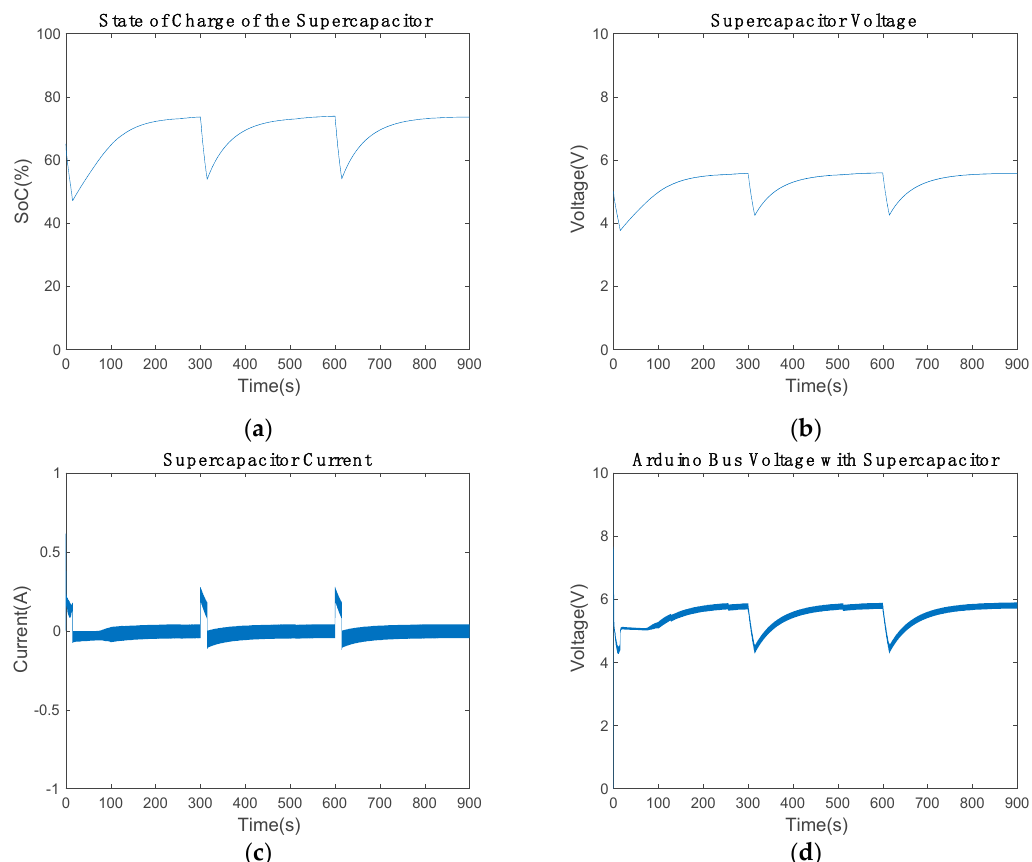
Figure 13. Medium-power harvester results: ( a ) state of charge during 900 s, ( b ) voltage of the Sensors 2020 , 20 , x FOR PEER REVIEW supercapacitor, ( c ) current of the supercapacitor, and ( d ) the low-cost bus voltage. Table 6. Summary of the medium-power piezoelectric harvester results.